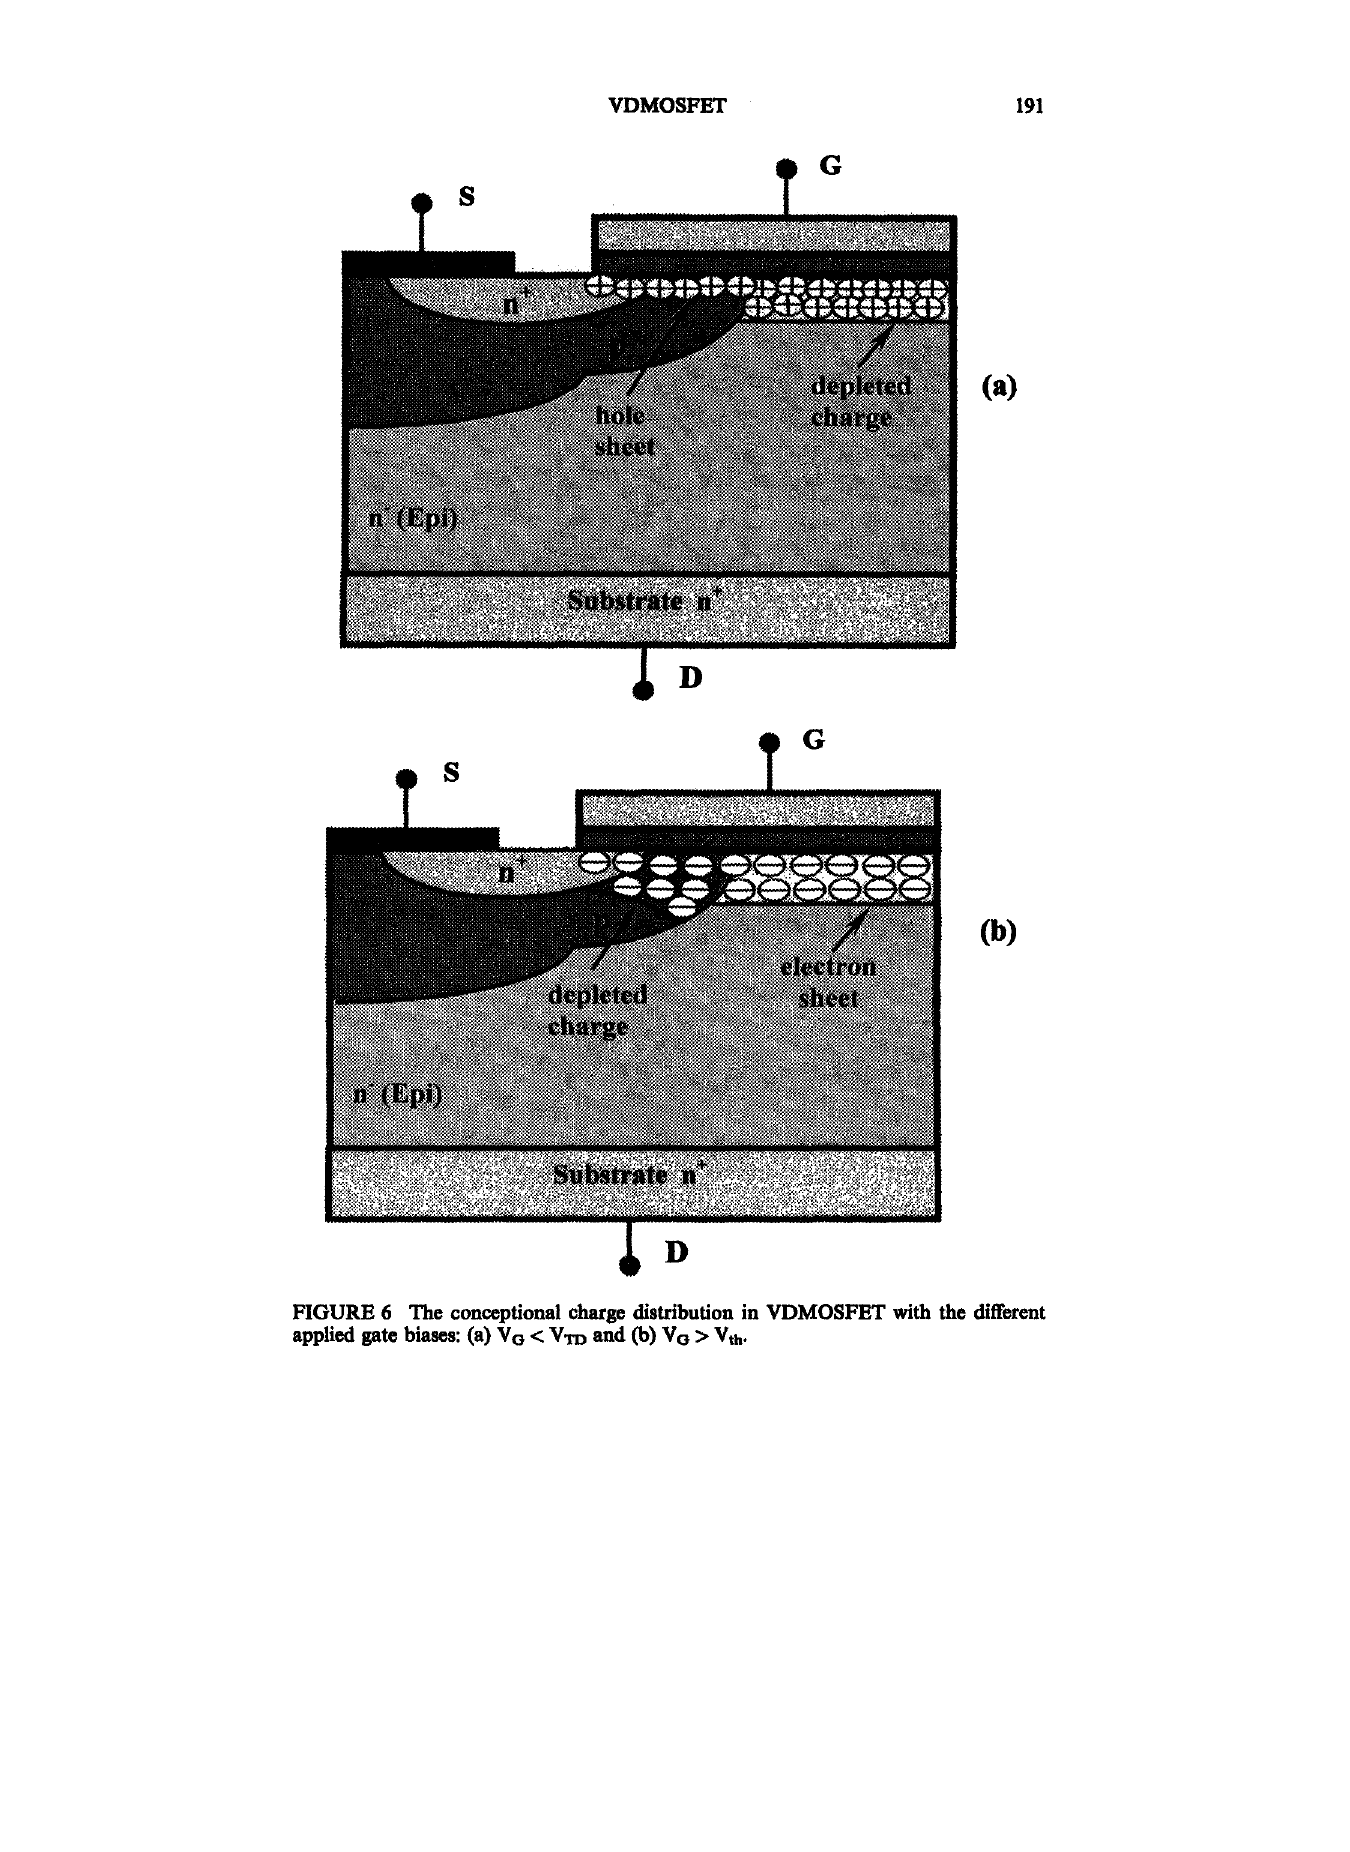
FIGURE 6 The conceptional charge distribution in VDMOSFET with the different applied gate biases: (a) V3 < VTD and (b) Vo >